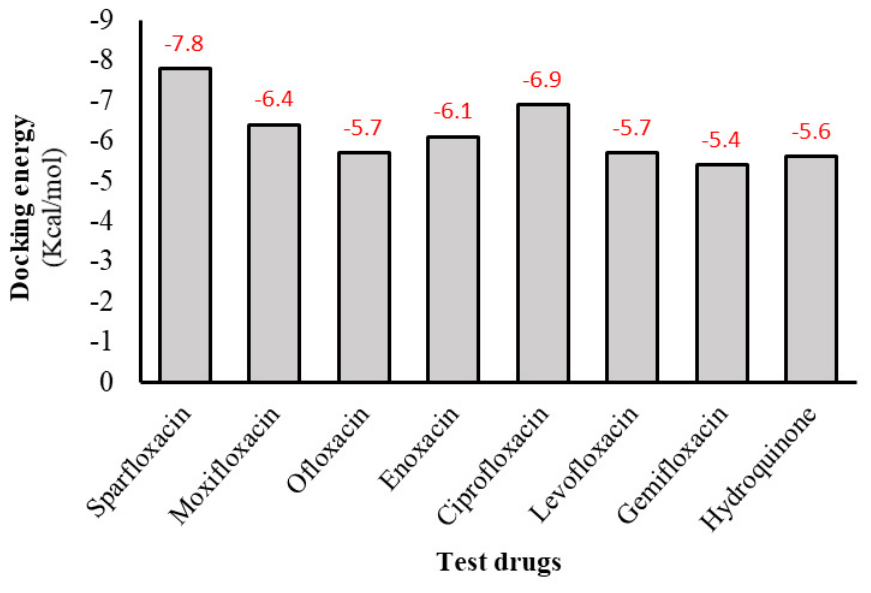
Figure 4. Molecular docking energy graph of test drugs.